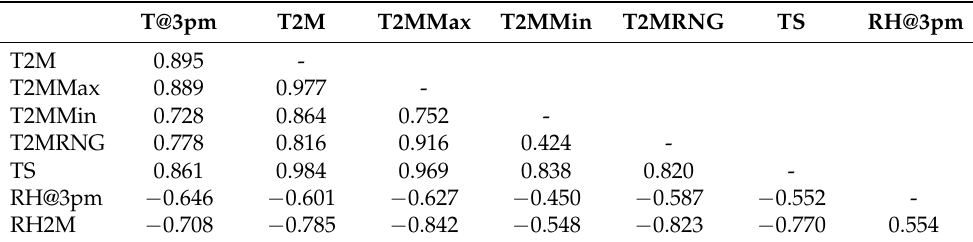
Table 2. Correlation between selected weather attributes at the time of pollination of